Question: Which visualization type does this figure use?
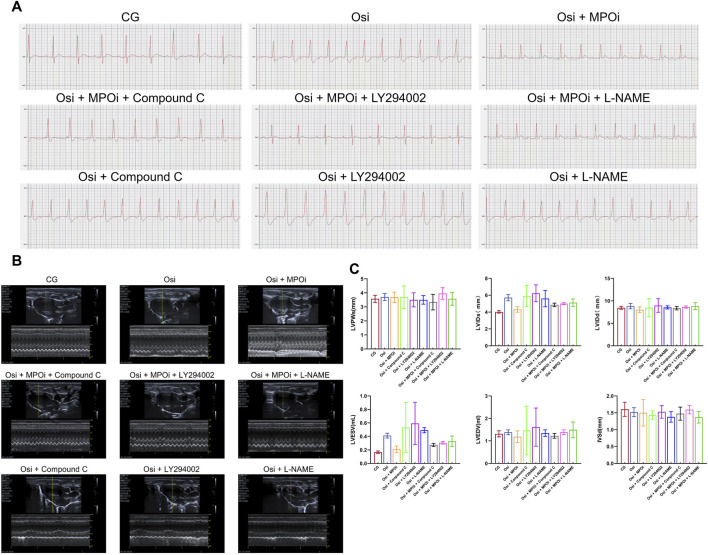
Answer: histogram